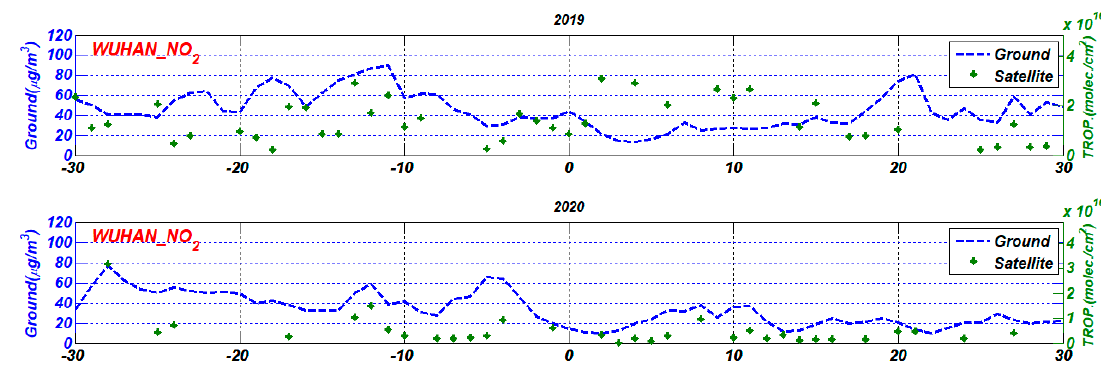
Figure 9. As Figure 6, for NO 2 concentrations in 2019 and 2020 (broken lines) and the collocated daily TROPOMI NO 2 tropospheric VCDs (crosses).